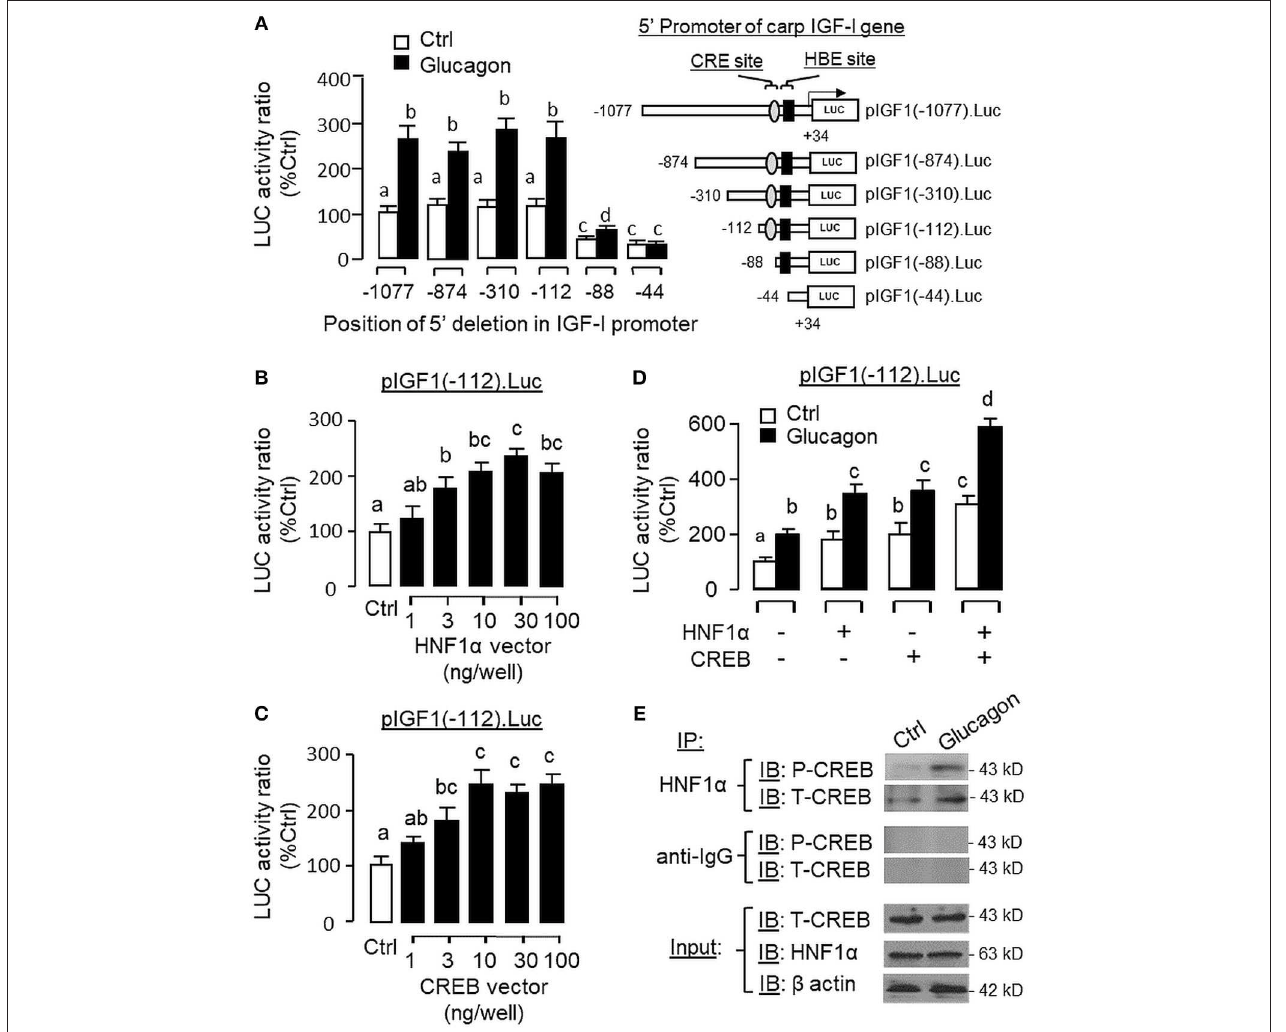
FIGURE 13 | Function role of HNF1 α and CREB in glucagon-induced IGF-I promoter activity in α T3 cells. (A) Mapping of glucagon responsive sequence to the proximal promoter of IGF-I gene with CRE and HBE sites. 5 ′ Deletion was conducted in the 1,077 bp promoter of pIGF1(-1077).Luc to generate a series of 5 ′ deleted Luc reporters with decreasing lengths of IGF-I promoter from position − 874 to − 44. These 5 ′ deletion constructs were then used for transfection study in α T3 cells followed by 24h treatment with glucagon (100nM). Over-expression of (B) HNF1 α and (C) CREB on IGF-I promoter activation. Co-transfection was performed in α T3 cells with pIGF1(-112).Luc (with CRE and HBE sites in proximal promoter) together with increasing levels of the expression vector for carp HNF1 α or CREB as indicated. (D) Functional interaction of HNF1 α and CREB on glucagon-induced IGF-I promoter activity expressed in α T3 cells. In parallel study with pIGF1(-112).Luc, similar transfection was conducted with the HNF1 α vector alone (30ng/ml), CREB vector alone (30ng/ml) or co-transfection with the two vectors (30 ng/well each). After that, the cells were treated with glucagon (100nM) for 24h. In our experiments with IGF-I promoter, cell lysate was prepared from α T3 cells after the drug treatment/transfection with expression vectors and used for luciferase activity measurement. (E) Protein:protein interaction of HNF1 α and CREB induced by glucagon in carp hepatocytes. Immunoprecipitation (IP) was performed in cell lysate prepared from carp hepatocytes after 1-h treatment with glucagon (10nM) using the antibody for HNF1 α . After that, the protein pull-down was subjected to immunoblotting (IB) with antibodies for phosphorylated and total protein of CREB (as “P-CREB” and “T-CREB,” respectively). In this experiment, parallel IP with the antibody for mouse IgG (as “anti-IgG”) was used as the negative control while the corresponding IB for HNF1 α , T-CREBk, and β actin were conducted in the cell lysate prior to the pull-down with HNF1 α antibody to serve as the input